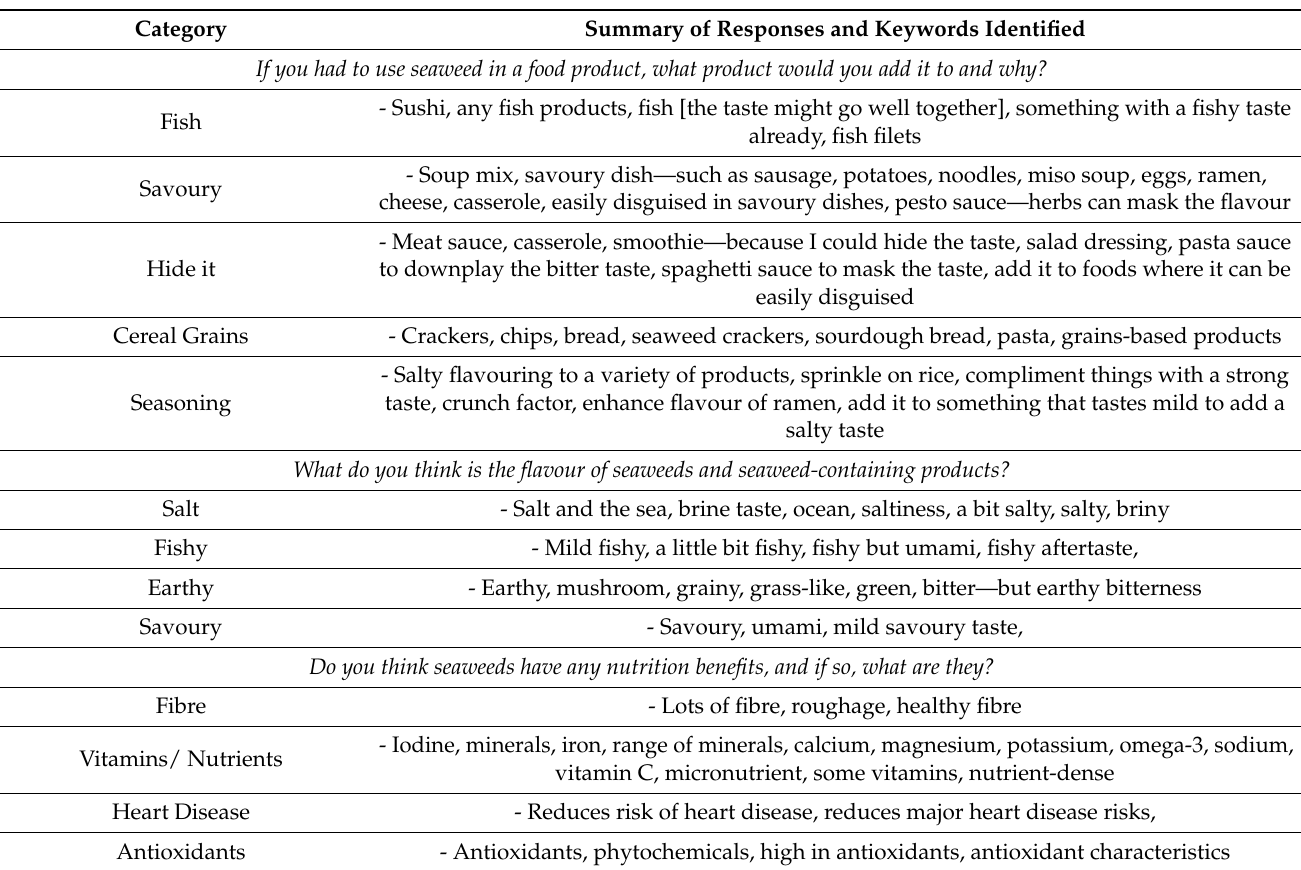
Table 2. Results of the comment analysis conducted on the open-ended comments pertaining to seaweeds (n = 108). Category Summary of Responses and Keywords